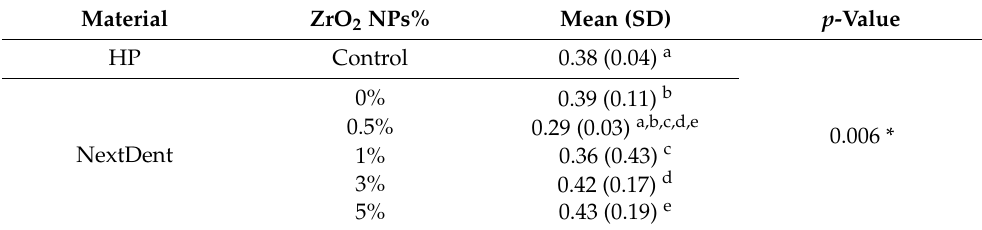
Table 3. Mean, SD, and significance of cell proliferation